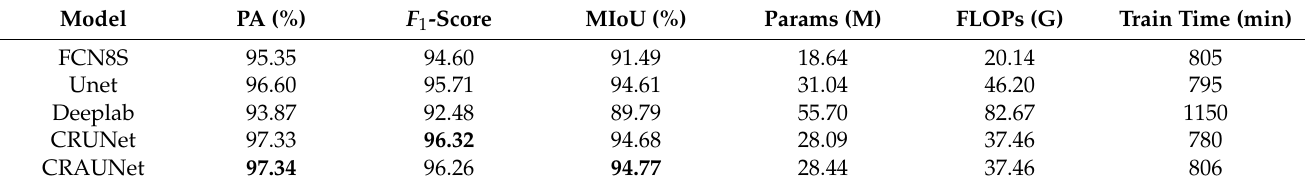
Table 4. Results on Green Space testing set. (Bold represents the best result).